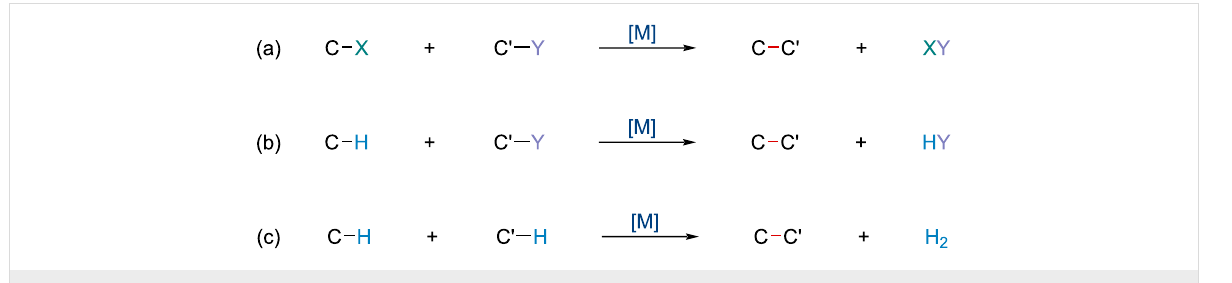
Scheme 1: Typical modes of C–C bond